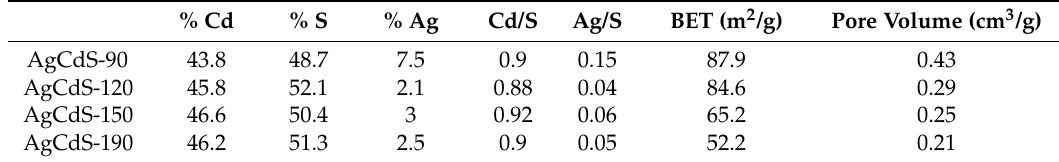
Table 1. Chemical composition (atomic %) from TXRF and textural data from N 2 isotherms of the AgCdS-T photocatalysts.